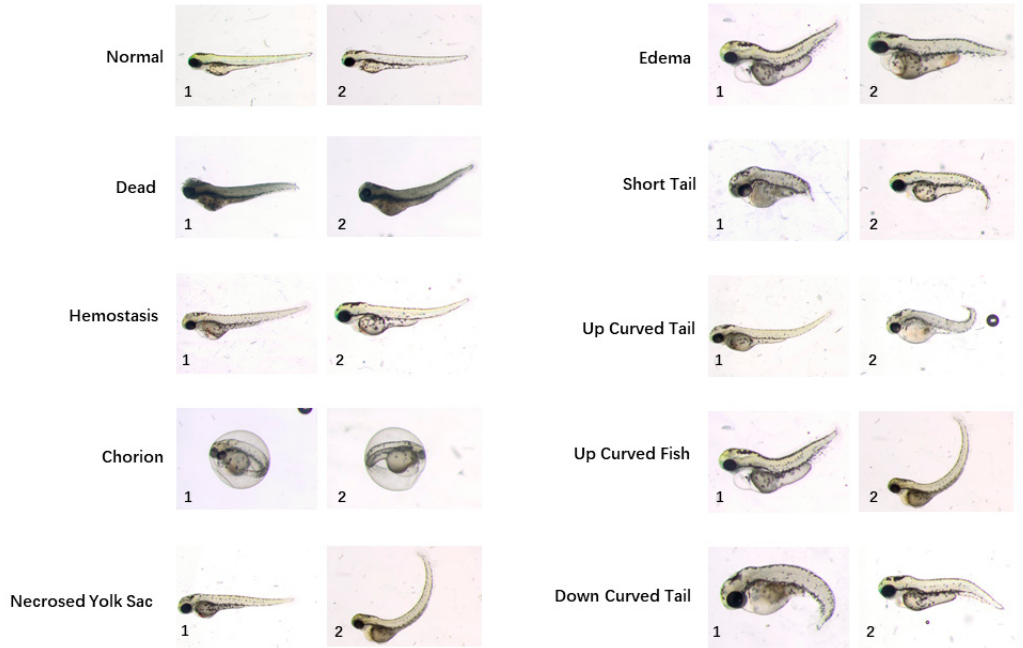
Figure 1. Example images of ten zebrafish larvae phenotypes from the publicly available dataset provided by Jeanray et al. A detailed description of these phenotypes are referred to the original paper of this dataset [20]. Note that some larvae have multiple phenotype labels, such as the larva of “edema 1” and “up curved fish 1”, as well as the larva of “necrosed yolk sac 2” and “up curved fish